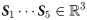
The local-manipulation algorithm, which combines base-manipulation with tip steering is presented.(a) Simplified 3D representation of the local-manipulation algorithm. The needle is inserted into the tissue. Part of the needle which is in the tissue is divided into 5 segments (solid black lines), which are approximated by polynomials (S1⋯S5∈R3). Pt,1⋯Pt,4∈R3 show the position of the needle points at time t. P0,1⋯P0,4∈R3 show the initial position of the needle at positions (1) to (4). Green arrows show the force (Fi∈R3×1) applied to each point on the needle using Eq (5). The light blue arrow represents the force at the tip due to the bevel (Ftip) calculated using Eq (8), which is used in tip-steering method. Frame (Ψi) depicts the fixed initial frame at the insertion point. The dark blue arrow shows the needle orientation at the insertion point. (b) The needle orientation at the insertion point (blue arrow) is calculated using the inverse kinematics. The orientation is presented using the angles (γ) and (ψ). These two angles are the inputs for the needle insertion setup. (c) The parameters used to calculate the force and the moment due to the bevel at the tip are presented. Bevel angle is denoted by α, and β is the cut angle of the needle.